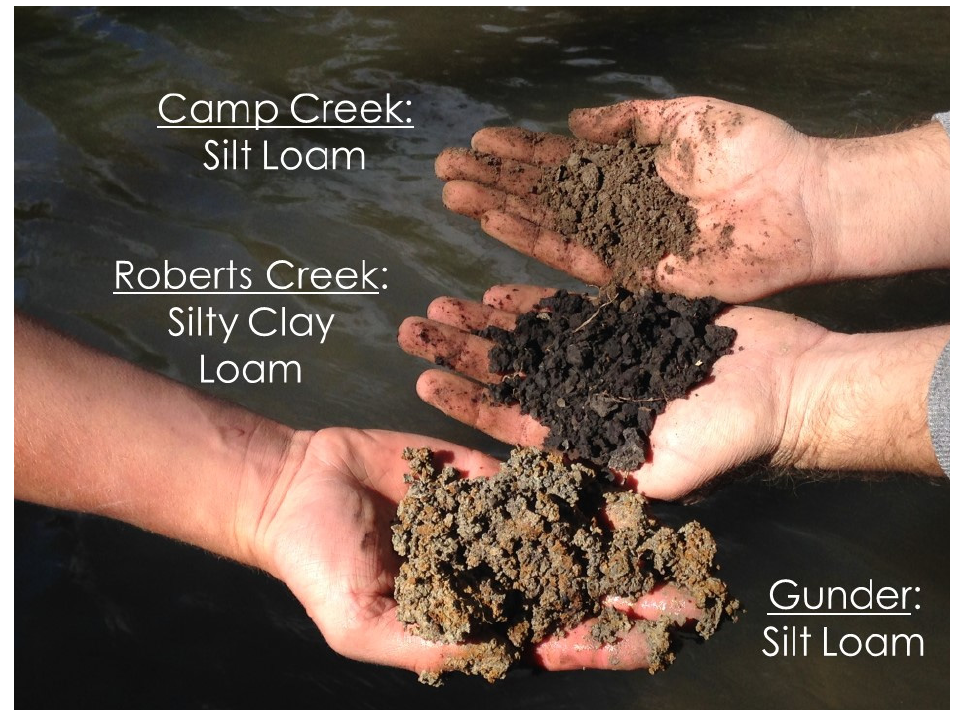
Figure 4. Extracted soil that highlights the color and texture of the Camp Creek, Roberts Creek, and Gunder alluvial streambank units, Walnut Creek, Iowa. Photo credit Hanna McBrearty, Iowa State University.